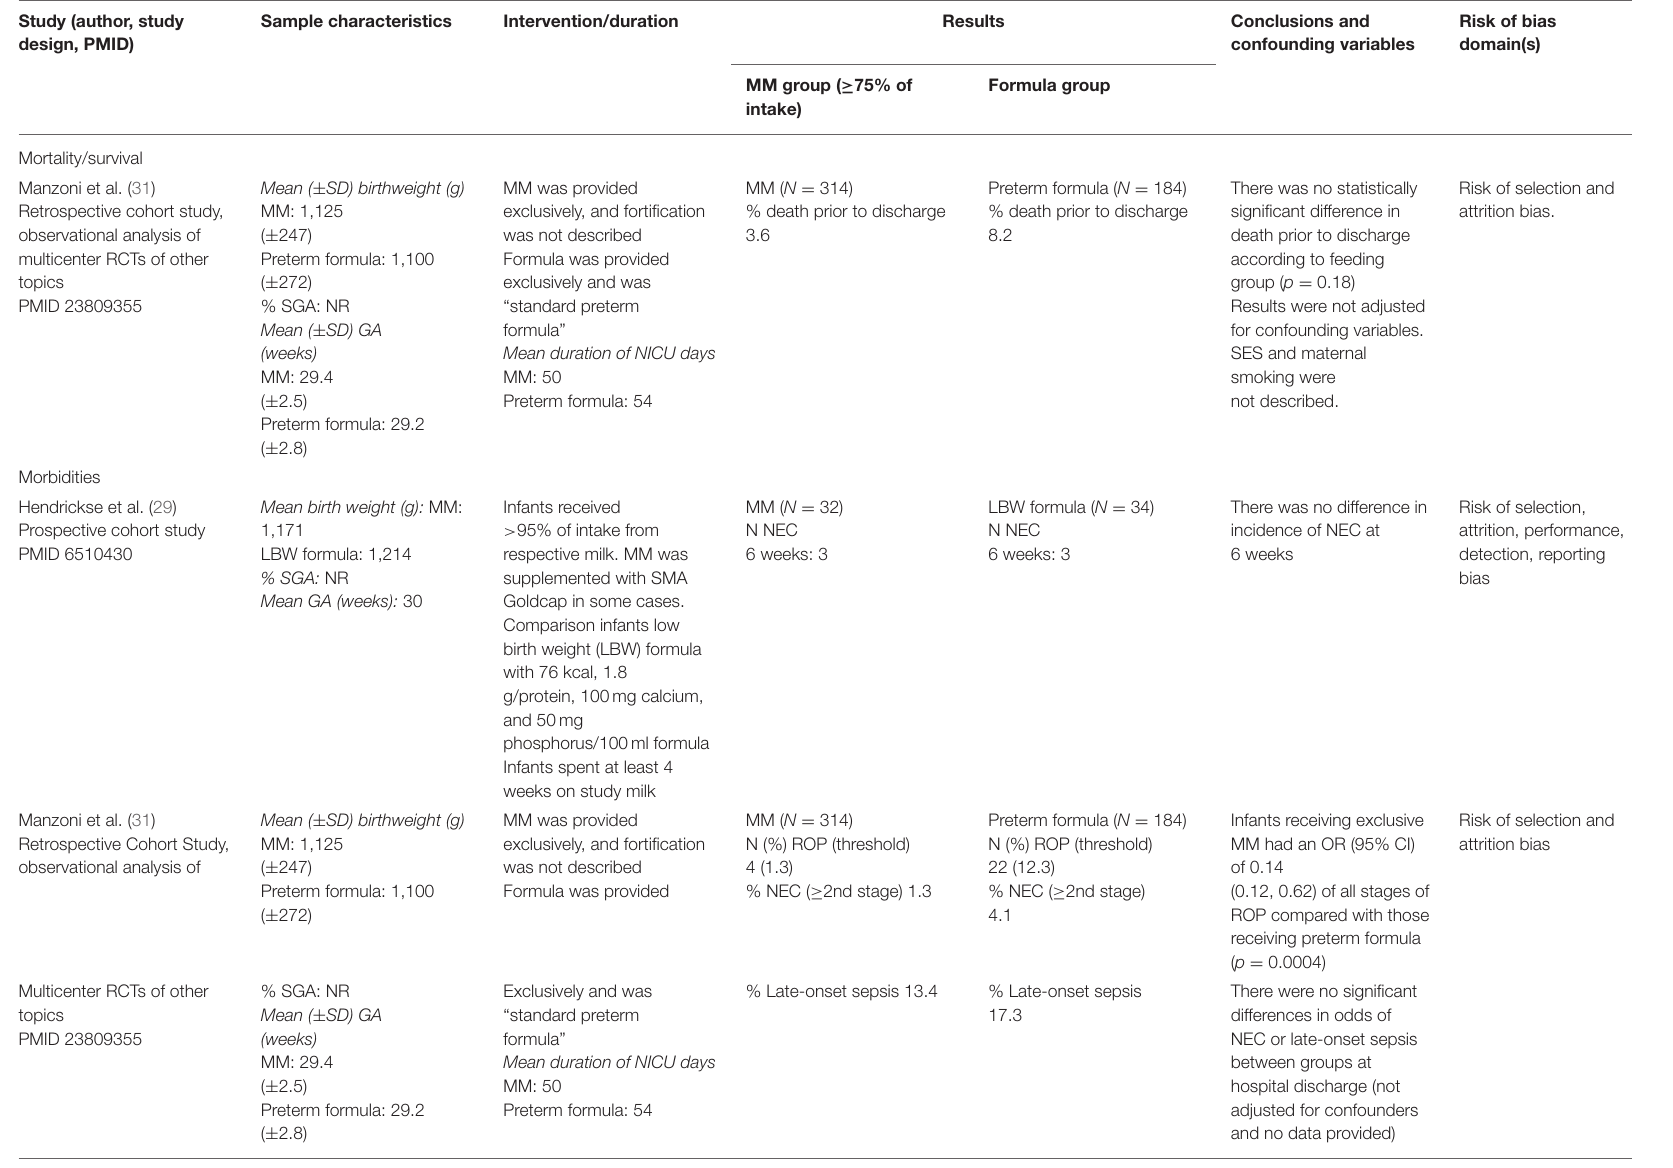
TABLE 2 | Study characteristics and results of articles evaluating the association between ≥ 75% MM and exclusive formula intake and growth and health outcomes in VLBW ( ≤ 1,500g) preterm infants. Study (author, study design,